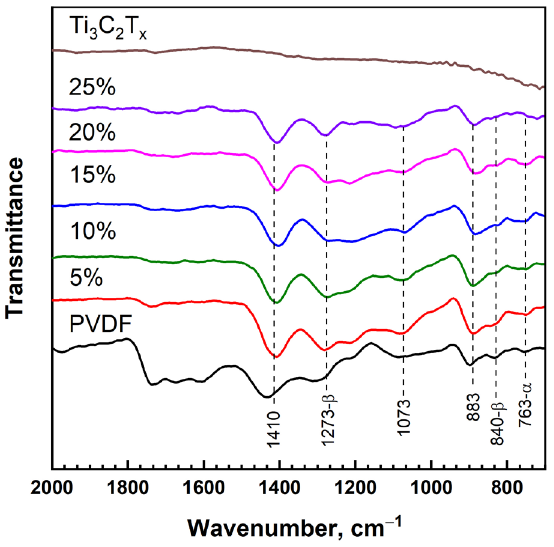
Figure 3. FTIR spectra of pure PVDF, Ti 3 C 2 T x MXene, and polymer nanocomposites with different MXene loadings.